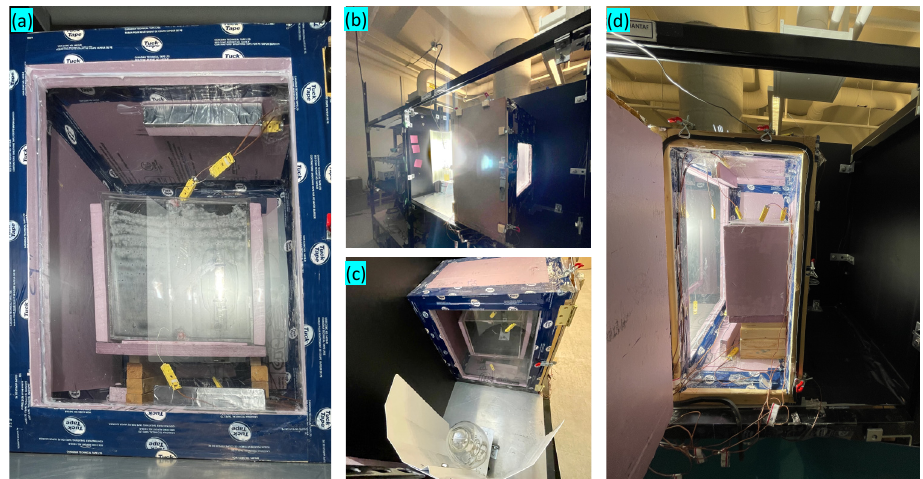
Figure 1. ( a ) Front view of the Trombe wall prototype when water with acrylic tinted plexiglass was used ( b ) Rear view of the transparent Trombe wall prototype showing the plexiglass at its rear side ( c ) Trombe wall prototype with a 1000 W metal halide light functioning as a solar simulator ( d ) Side view of the Trombe wall prototype with the door open.